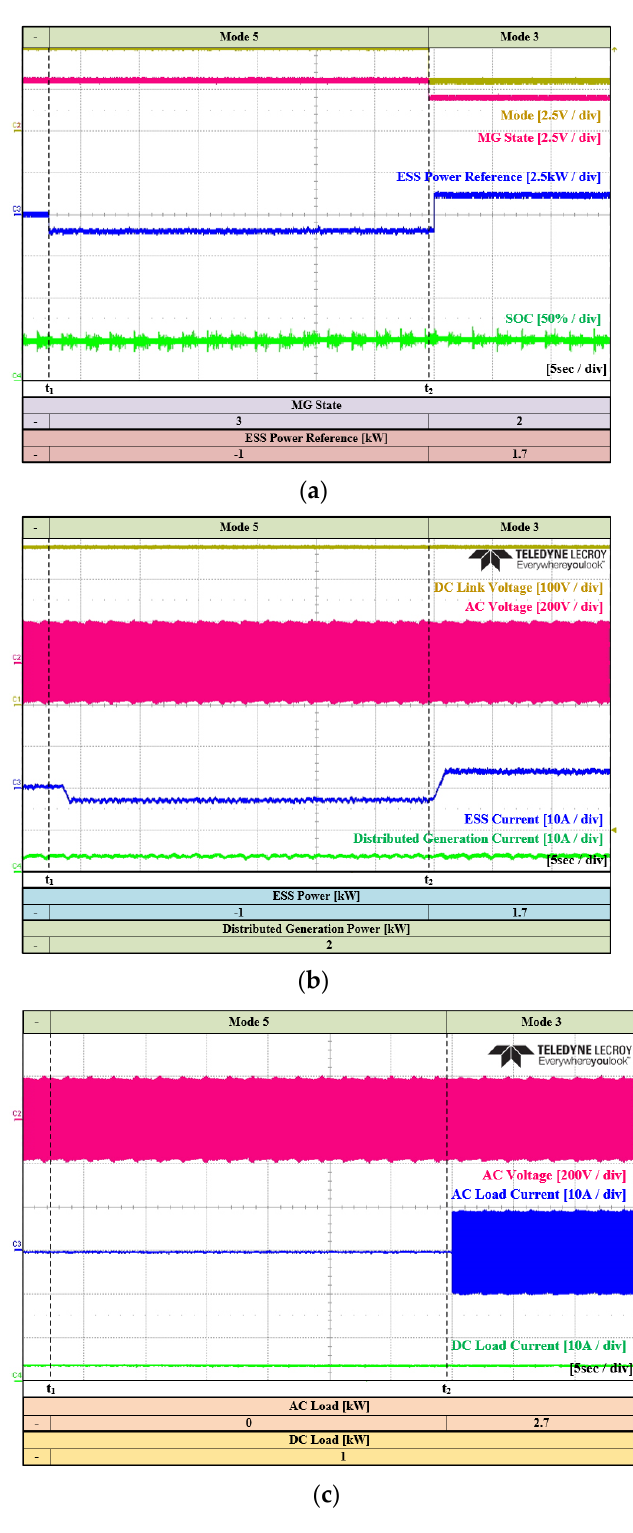
Figure 26. Experimental waveforms of standalone Modes 5 and 3. ( a ) Waveforms of the input data (MG state, SOC) and output data (Mode, ESS power reference) of the ANN. ( b ) Waveforms of DC link and AC voltage, ESS, and DG current. ( c ) Waveforms of each load current and AC grid volt- age.